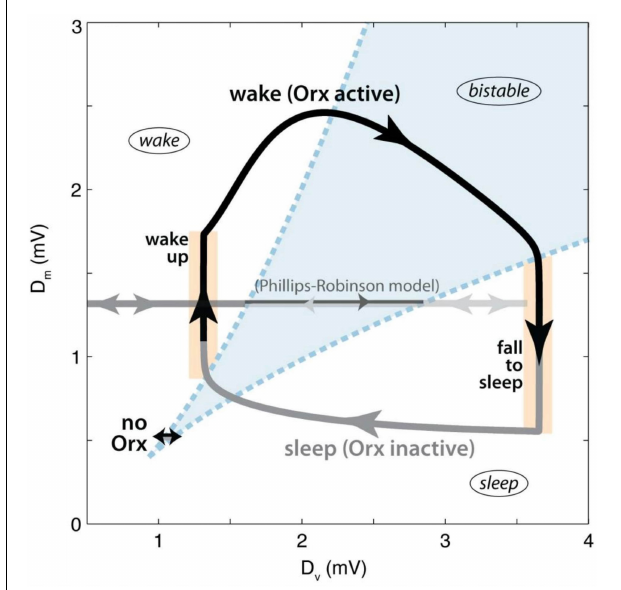
FIGURE 5 | Dynamics of orexin stabilisation of state transitions according to the model of Fulcher et al. (2014). The axes represent the net drives to the wake-promoting (D M ) and sleep-promoting (D V ) circuits. Regions are labelled, with the bistable region shown in blue. The black arrow represents the waking period, while the grey arrow represents sleep. The trajectory marked “no Orx” represents the dynamics of the model in the absence of orexin input. Figure adapted from Figure 3 of Fulcher et al. (2014), published under CC-BY